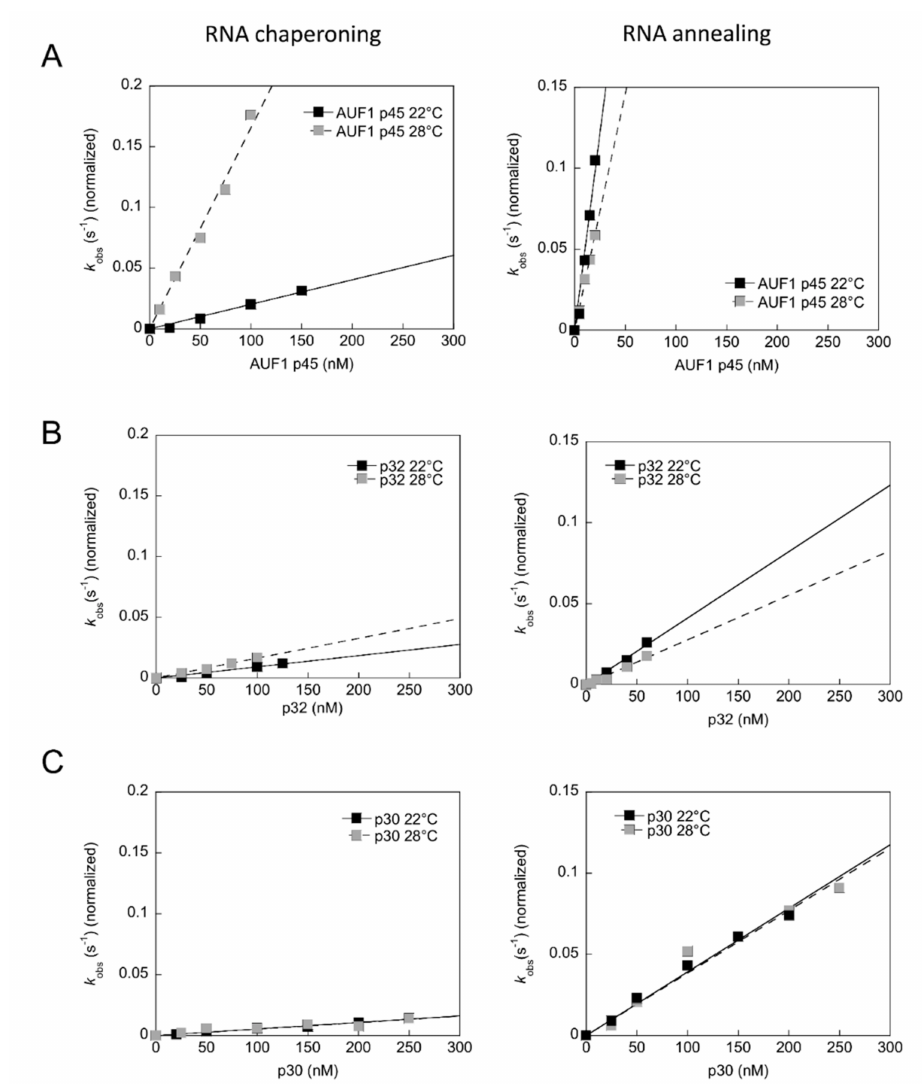
Figure 8. The e ff ect of temperature on rates of RNA chaperoning and RNA annealing reactions. The RNA chaperoning (left) and RNA annealing (right) reactions in the presence of AUF1 p45 ( A ), p32 ( B ), or p30 ( C ) were performed at 22 ◦ C and 28 ◦ C. The rate constants were normalized by subtracting the non-enzymatic rate from the total rate and plotted as a function of the protein